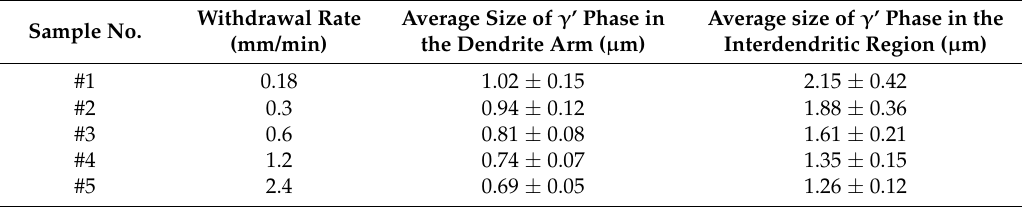
Table 3. Average sizes of the γ ’ phases in the dendrite arms and interdendritic regions of GH4720Li superalloy samples prepared at different withdrawal rates.